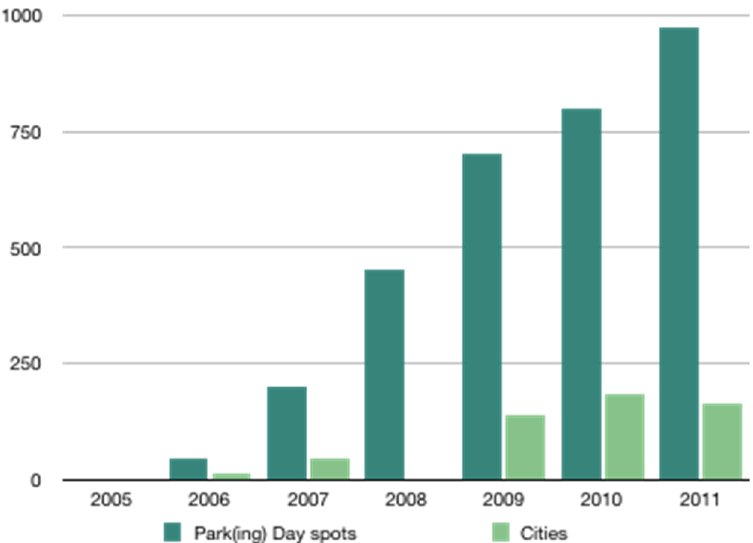
Figure 2. Growth of Park(ing) Days (PD) from 1 spot in 1 city (2005) to 975 parks created in 162 cities in 35 counties in 2011 (last year of formal counts) [20]. No data for the number of cities participating in 2008. Based on data from press releases and Coombs G. [19].